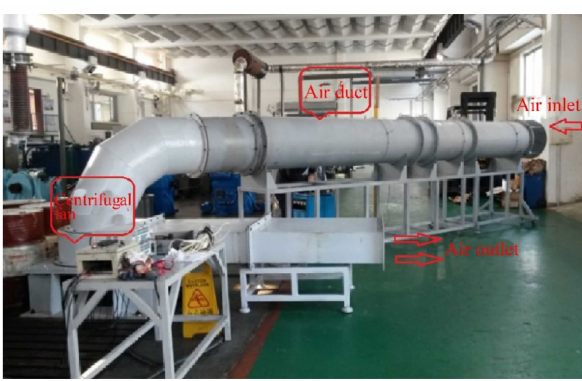
Figure 1. Centrifugal fan testbed.